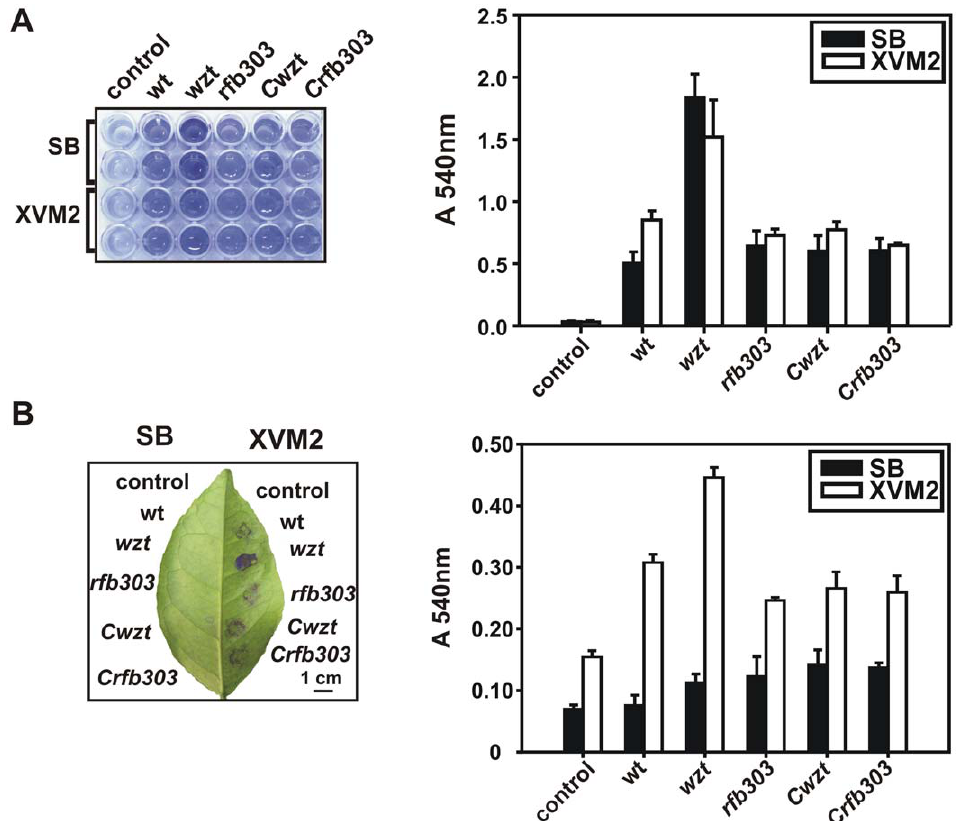
Figure 4. Bacterial adhesion to abiotic and biotic surfaces. (A) Bacterial adhesion on plastic (PVC microtiter plate) surface of Xac wild-type, Xac wzt , Xac rfb303 , Xac Cwzt and Xac Crfb303 strains grown in SB or XVM2 medium. (B) Bacterial adhesion on abaxial orange leaves surfaces. In the left, representative images of CV staining of a PVC plate or a leaf are shown. Histograms in the right represents spectrophotometric quantifications of CV attached (Abs 540 nm). Data are expressed as the mean 6 standard deviation of three independent experiments. Scale bar, 1 cm.